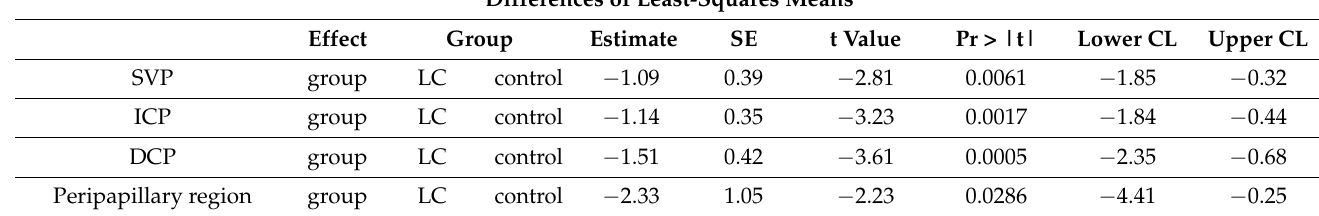
Table 1. Retinal microcirculation of patients with Long COVID (LC) compared to controls, quantified by macula (SVP, ICP, DCP) and peripapillary vessel density of OCT–A scans; SVP—superficial vascular plexus; ICP—intermediate capillary plexus; DCP—deep capillary plexus; SE—standard error. The estimates are represented as the differences between the seronegativity estimate and the seropositivity estimate with the lower and upper confidence limits